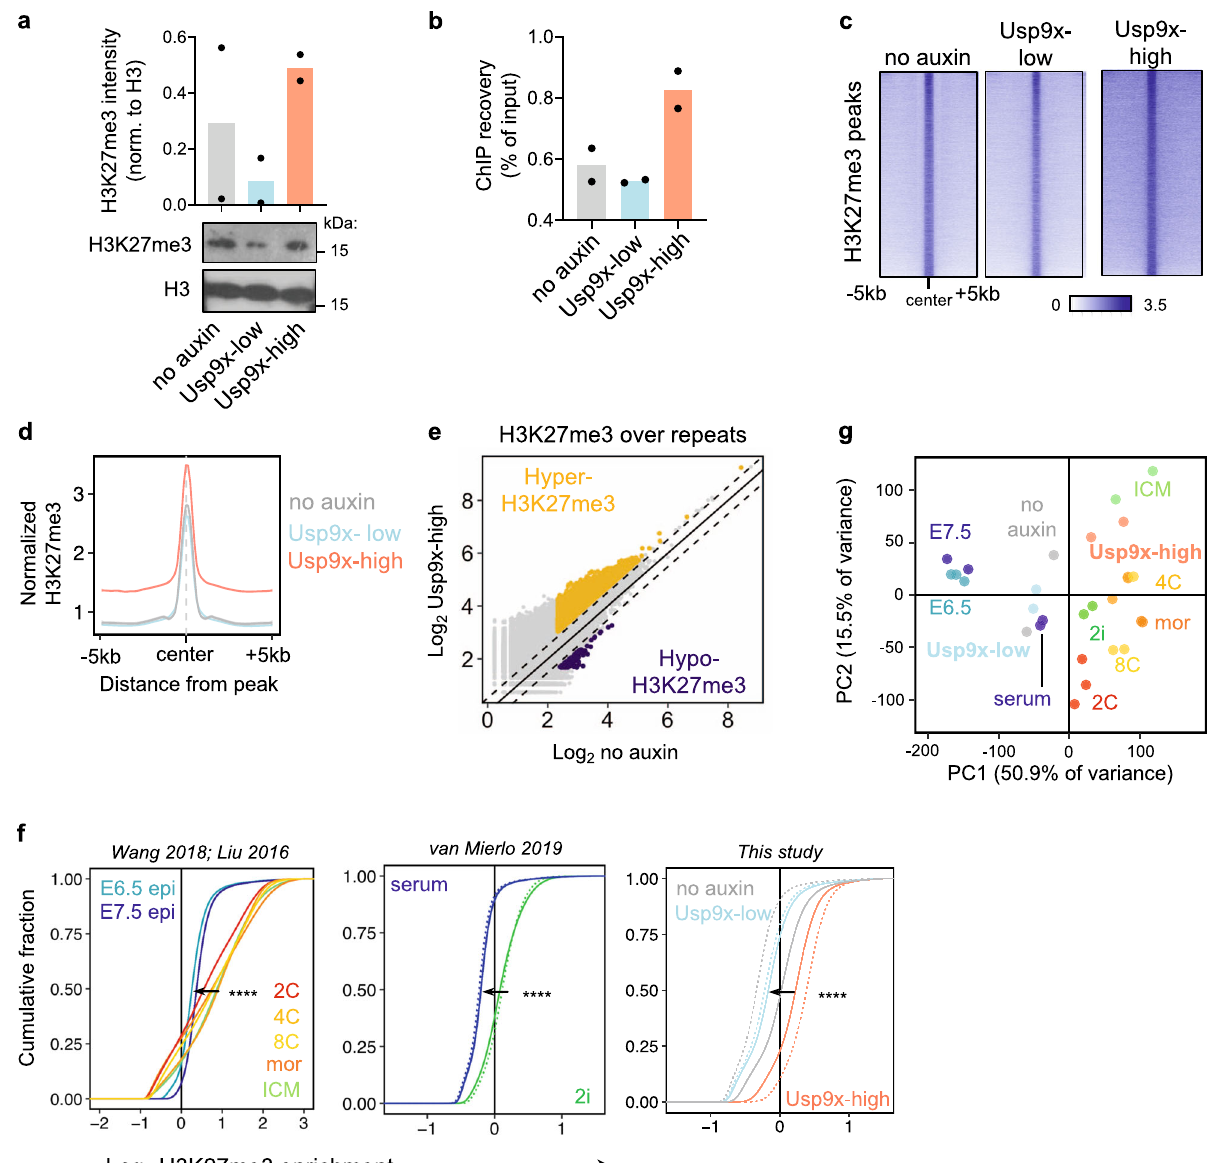
Fig. 3 Usp9x mediates a pre- to postimplantation switch in global H3K27me3 levels. a Quanti fi cation and representative western blot of H3K27me3 from histone extracts. b ChIP recovery before sequencing recapitulates the global gain of H3K27me3 in Usp9x-high ES cells. c Heatmaps of H3K27me3 ChIP-seq signal in Usp9x-high and Usp9x-low ES cells, showing H3K27me3 spreading in Usp9x-high cells. d Pro fi le plot depicting the mean signal of coverage shown in c . e Usp9x-high ES cells carry more H3K27me3 over repetitive elements compared to untreated (no-auxin) cells. Each point represents an individual element. Dotted lines are |log 2 (0.7)|. f Cumulative enrichment plots of H3K27me3 enrichment in non-overlapping genomic bins of in vivo developmental stages (left) and ES cell states (middle, right) 11,59,62 . Preimplantation stages (2C-ICM, top) or preimplantation-like ES cell states (2i, Usp9x- high) display H3K27me3 enrichment. Epi, epiblast; mor. morula; ICM, inner cell mass. Enrichment ( x -axis) is log 2 (H3K27me3/input + 0.5). g PCA plot clustering Usp9x-high and Usp9x-low ES cells among the samples shown in f based on genome-wide H3K27me3 distributions. Each point represents a biological replicate. Data are mean of two biological replicates ( a , b ), sum of two biological replicates ( d , e ). **** P < 2.2 × 10 − 16 by two-tailed Kolmogorov – Smirnov test comparing the average of biological